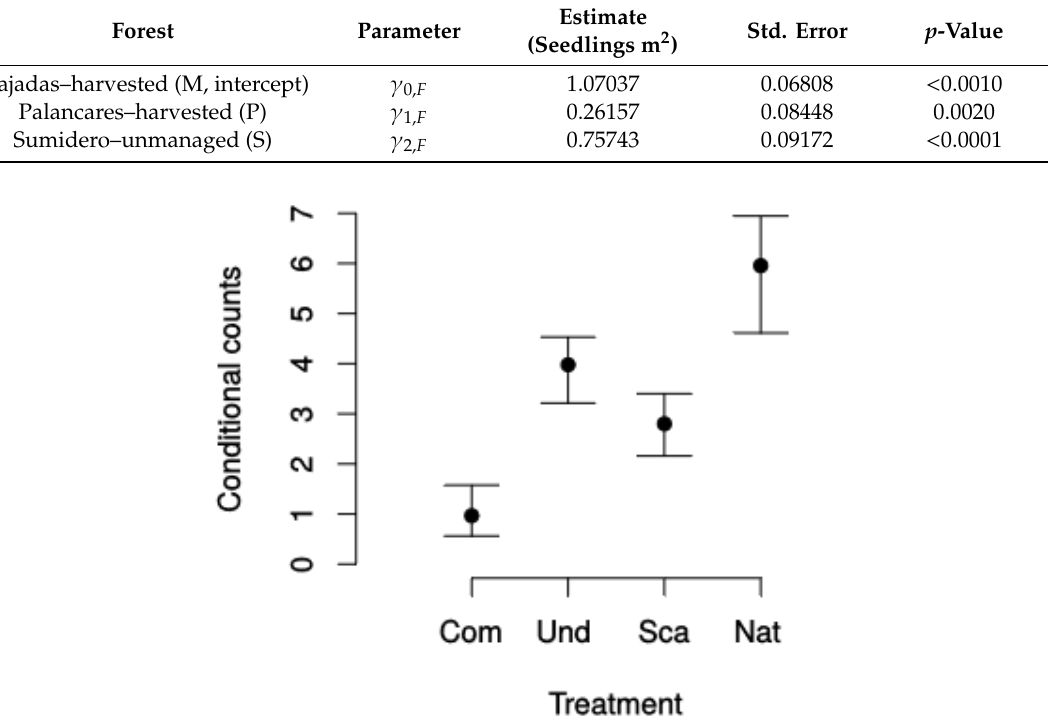
Figure 2. Zero-inflated model predictions and confidence intervals of number of recruits after treatments per m 2 (Com = Compaction; Und = Undisturbed; Sca = Scarification; Nat = Natural (Sumidero)) in three Spanish black pine forests (Cuenca Mountains, Spain).